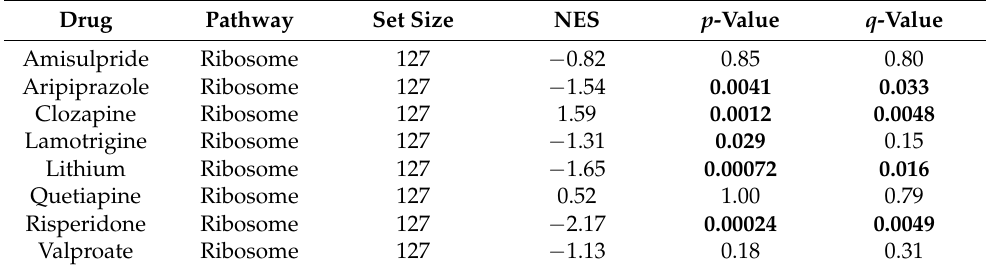
Table 1. GSEA of effects of 8 psychotropic drugs on NT2-N cells.